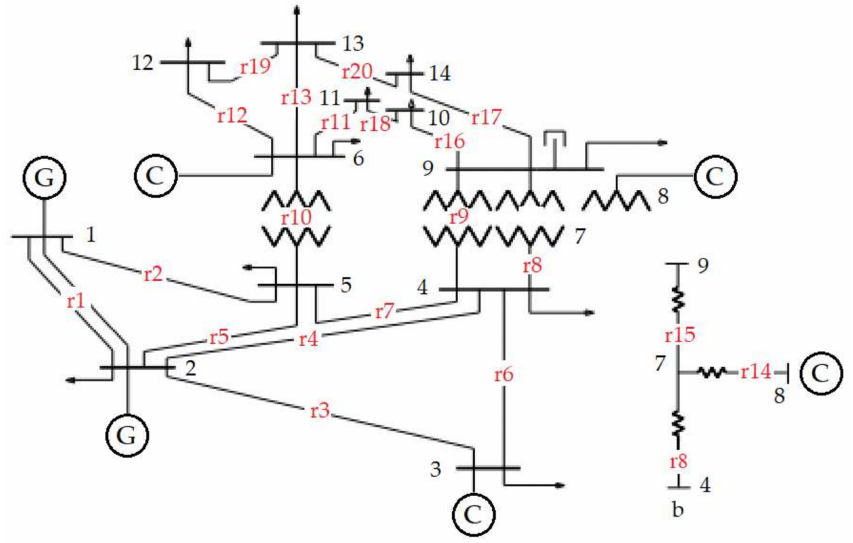
Figure 1. IEEE 14-bus system with the respective branches r